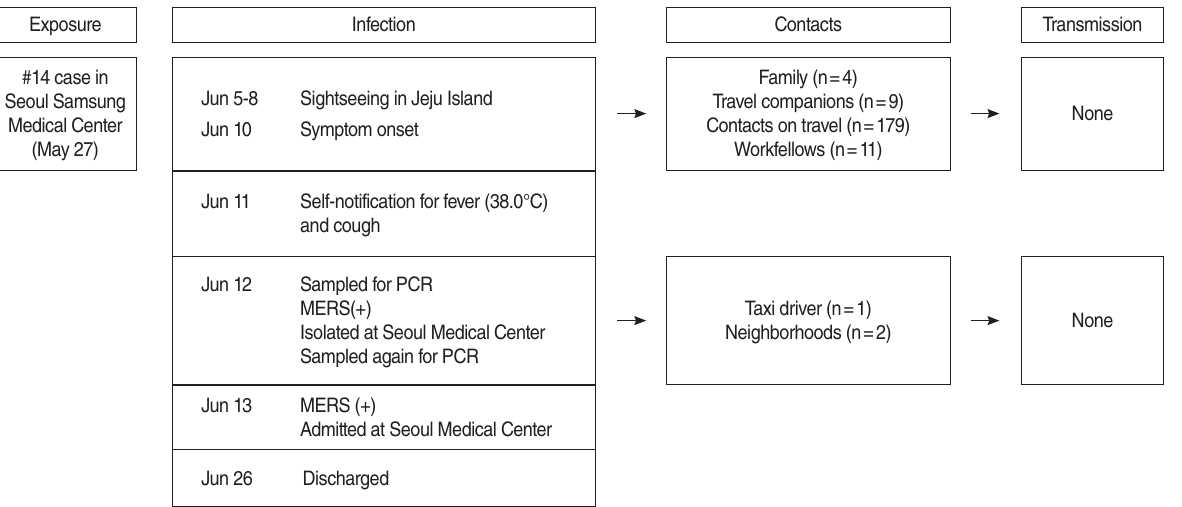
Figure 1. Main events by date for 141st confirmed Middle East Respiratory Syndrome (MERS) case in Korea. PCR, polymerase chain